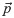
A cartoon illustrating cell migration.Migration transition rate (Eq (7)) is illustrated for a cell coloured in green. Its nucleus is marked with a green star. The motility of this cell depends on the ECM density, ci, in the voxel where its nucleus is situated (accounted for by the S(⋅) function (Eq (8)). The green cell forms cell-cell adhesions with other cells coloured in red. In this work, we assume a circular neighbourhood for cell-cell interactions within the so-called interaction radius, Rc, for the cellular scale (here it is drawn to have the same value as in our simulations, Rc = 1.5h, where h is the voxel width). This allows cells to interact beyond their immediate neighbours as, for example, the cell with the nucleus marked by a red star and the focal green cell. Other geometries (e.g. elliptical neighbourhood aligned with cell polarity vector) are unlikely to alter the model behaviour significantly since, in sprouting structures, lateral regions of the circular neighbourhood, which would be ignored by an elliptic neighbourhood, are typically empty. Cell-cell adhesion is accounted for by the neighbourhood function, F(⋅), Eq (9). The individual cell polarity, ϕ, is sampled from the von Mises distribution (Eq (12)) with the mean value given by the mean polarization direction, p→ (calculated as a function of local ECM fibril alignment, li, Eq (13)). The distribution spread, κ, is assumed to depend on the focal cell phenotype and the concentration of the BM components, Eq (14).